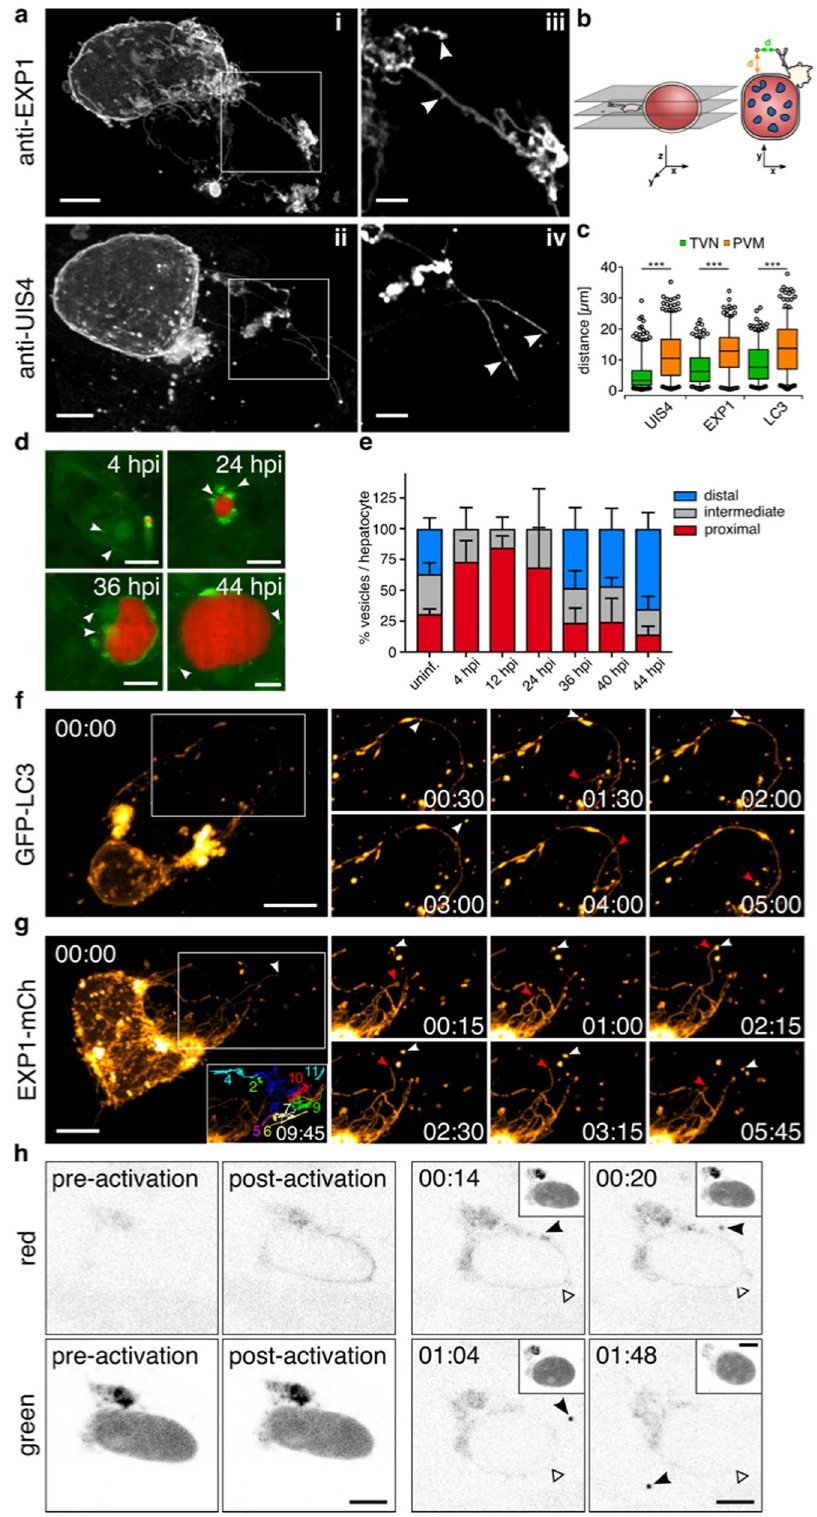
Figure 5. TVN-architecture and vesicle shedding in liver schizonts. (a) 3D reconstructions of the PVM/ TVN architecture. Young liver schizonts (36 hpi) were labelled for the indicated PVM proteins by immunofluorescence and images acquired by confocal laser scanning microscopy (3D-CLSM) with 0.22 µ m z-increments. The TVN consists of branched tubular structures, several node-like clusters and vesicles. iii, iv , Magnifications of a single z-plane. Potential budding sites or “growth cones” (arrowheads) are visible along protrusions and TVN-clusters. (b , c) The origin of the parasite-derived vesicles was determined based on the scattering pattern in the infected host cell. (b) Schematic of the analysis performed on Pb mCherry